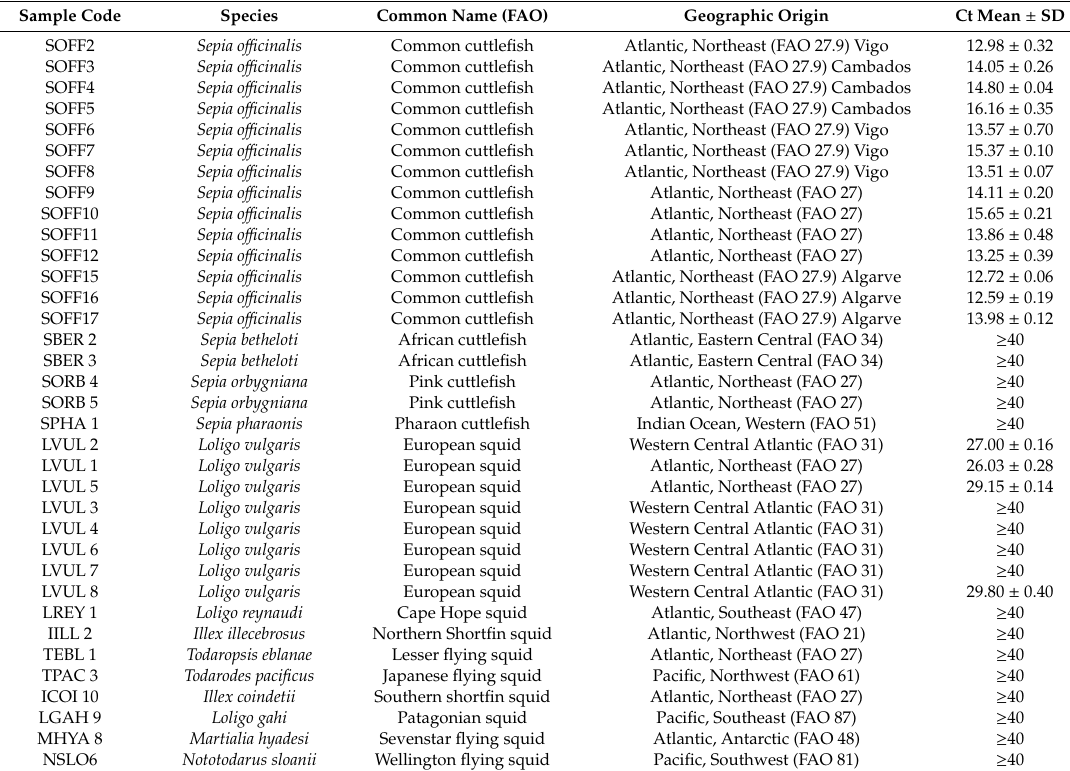
Table 1. Reference samples used in this study and threshold cycle (Ct)